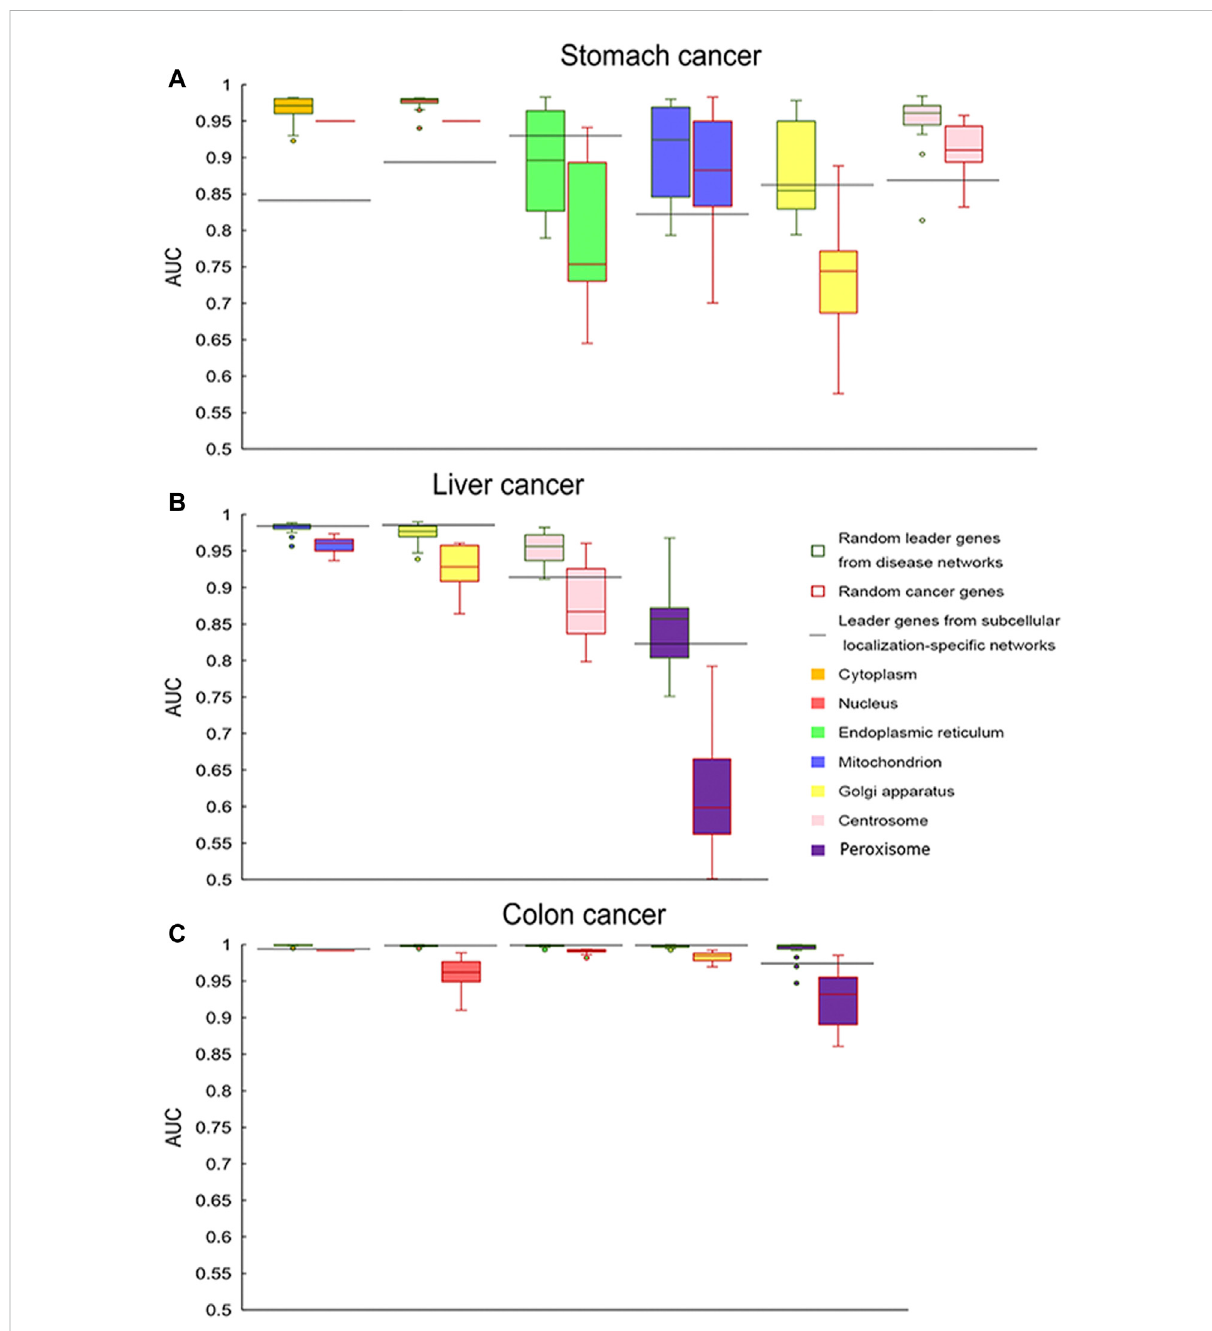
FIGURE 4 Classi fi cation comparison (AUC values) for three types of genes. Leader genes from subcellular location-speci fi c networks are represented by horizontal lines, and random genes from disease networks and random cancer genes are represented by box plots. Different fi lled colors represent different subcellular locations. (A) Stomach cancer, (B) liver cancer, and (C) colon